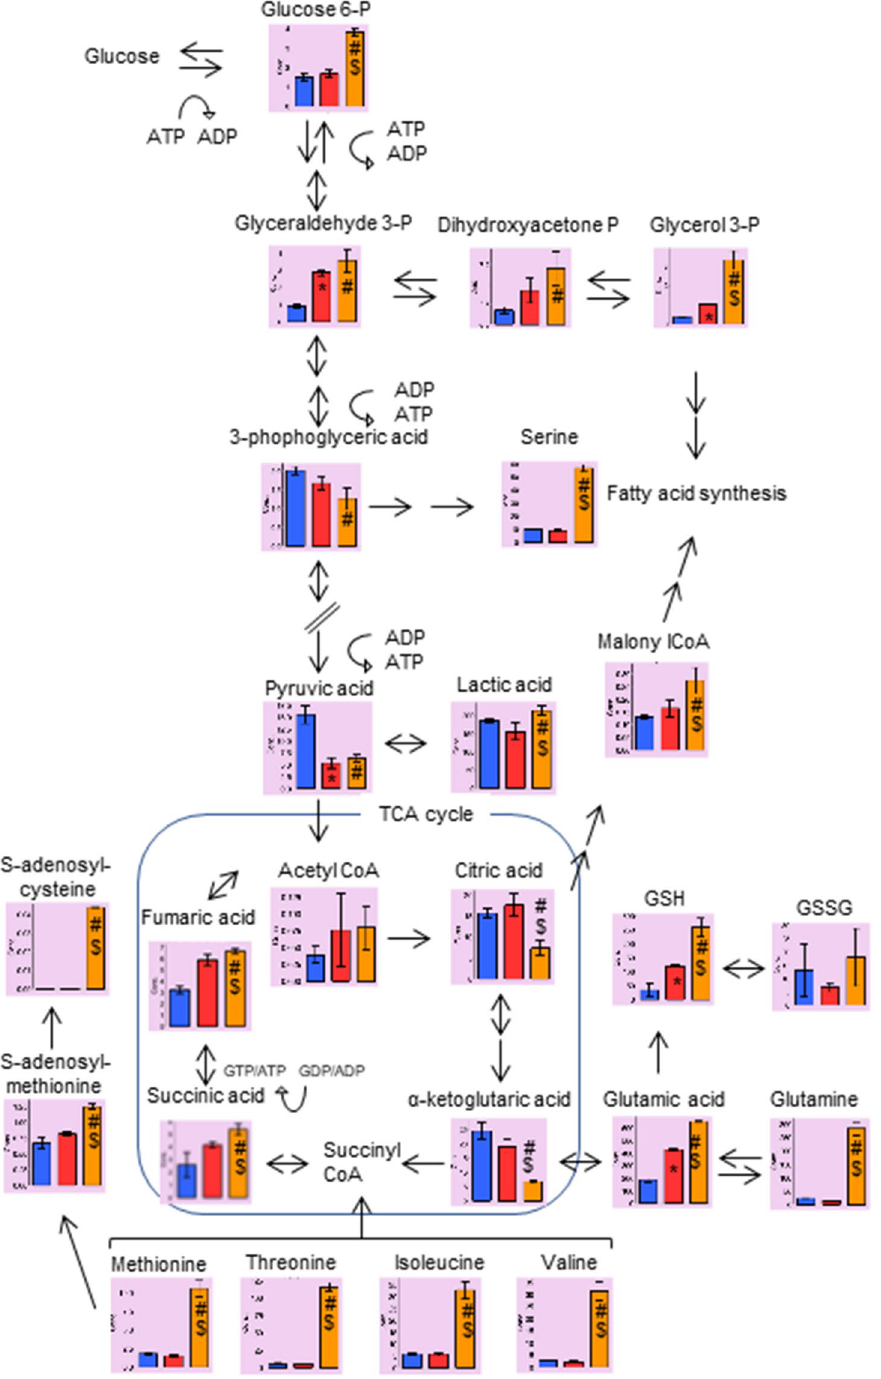
Figure 2. Representative data on glycolysis, the TCA cycle, lipid metabolism, glutathione synthesis and methionine metabolism. Blue, Nthy-ori 3-1; yellow, XTC.UC1; red with solid lines, TPC1; red with broken lines, TPC1 ρ0 cells. *, p < 0.01 vs. Nthy-ori 3-1; #, p < 0.01 vs. Nthy-ori 3-1; $, p < 0.01 vs. TPC1 cells. [Reproduced with permission from Human Metabolome Technologies, Inc., Tsuruoka, Japan with some